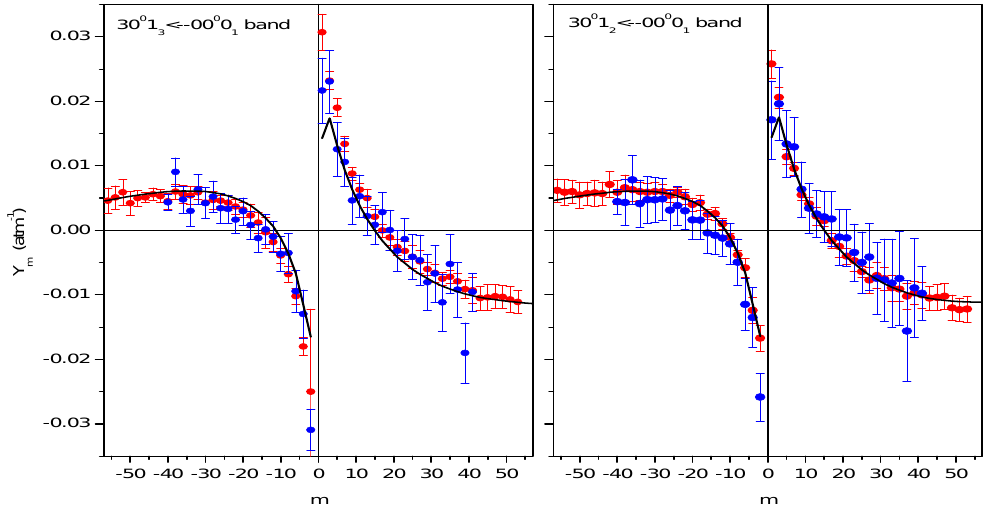
Fig. 1. Comparison of room temperature CO 2 -air first order LM coefficients from the theoretical database of Ref. (Niro et al., 2005c) (full lines) with experimental values obtained from multispectrum fits of laboratory spectra in Refs. (Malathy Devi et al., 2007a, b) (blue points), and (Predoi-Cross et al., 2007) (red points). Values are plotted vs. the rotational quantum number m ( m = − J i for P lines, m =J i +1 for R lines) and the error bars on these plots correspond to the one standard deviations given in Refs. (Malathy Devi et al., 2007a, b; Predoi-Cross et al., 2007) multiplied by 2 in order to represent the full confidence interval.